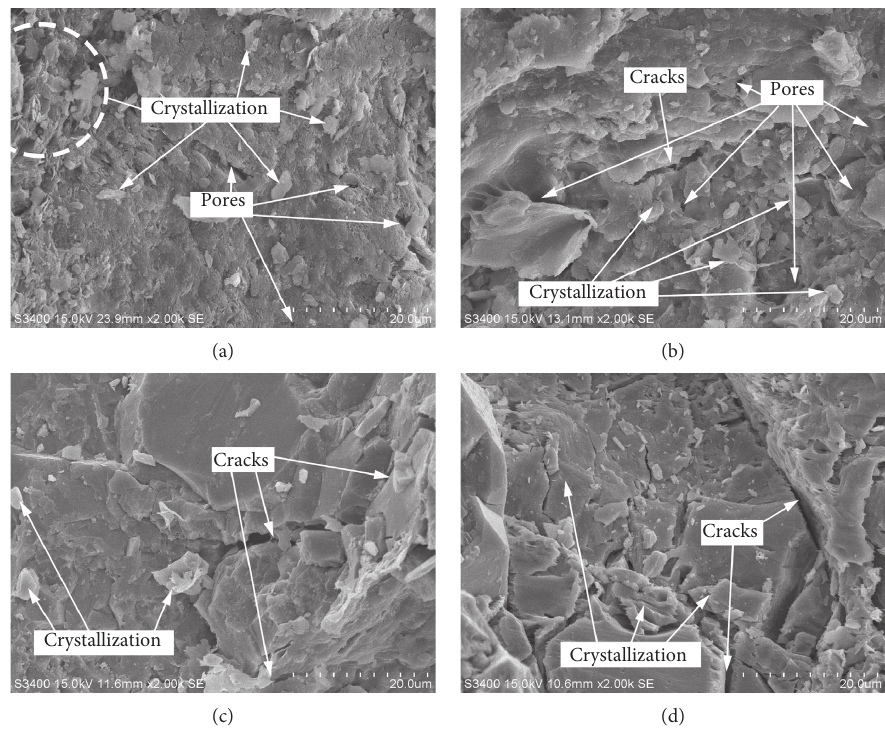
Figure 12: SEM image of specimens in different A-D-W cycle stages (at pH � 4): (a) Stage I, (b) Stage II, (c) Stage III, and (d) Stage IV.